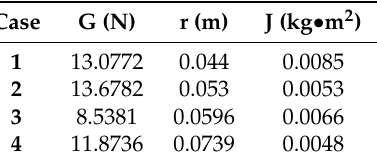
Table 9. Mismatch model parameters.